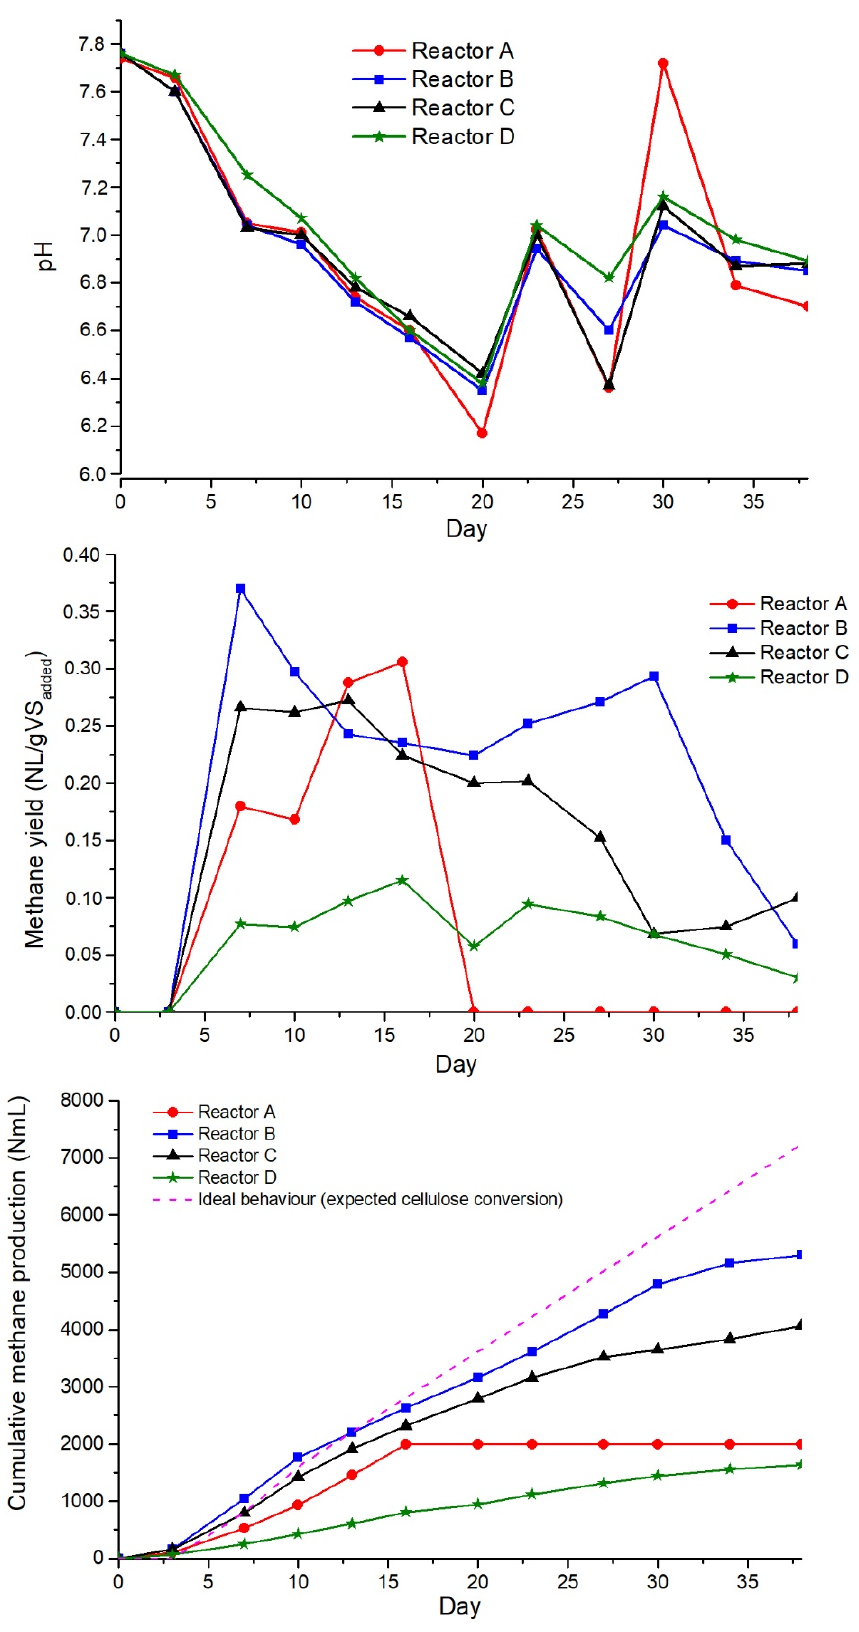
Figure 2. Anaerobic reactors pH trends, methane yields, and cumulative methane productions. During the first 2 weeks of operation, the methane amount produced by reactor B process was consistent with the expected production from the complete conversion of cel- lulose, whereas at the end of the test, the final cumulative methane production was about 5.3 NL; in fact, this reactor was the best performing, with a final production equal to about 75% of the expected one. Reactor C was the second-best process in terms of the cumulative volume of methane produced, with a final value of about 4.1 NL and a production close